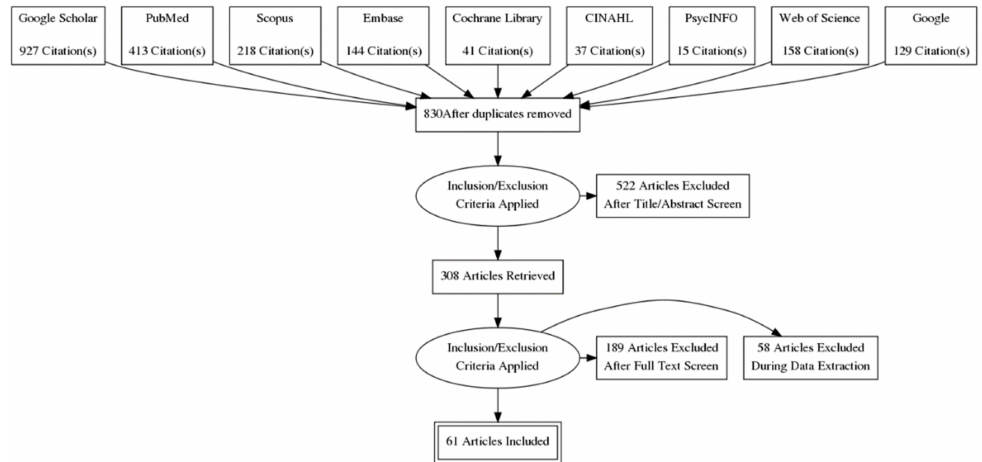
Figure 1. Flow diagram of the review process based on Preferred Reporting Items for Systematic reviews and Meta-Analyses (PRISMA) guidance [52]. The last search update was conducted